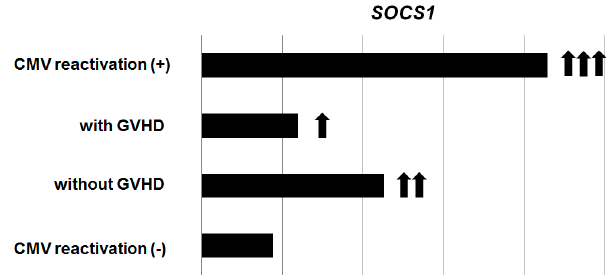
Figure 2. Expression of the SOCS1 gene in allogeneic hematopoietic stem cell transplantation recipients. Different expression of SOCS1 according to the cytomegalovirus reactivation and graft-versus-host diseases status (data modified from Blood Res 2015, 50, 40 – 45 [75]). Abbreviations: CMV, cytomegalovirus; GVHD, graft-versus-host diseases.